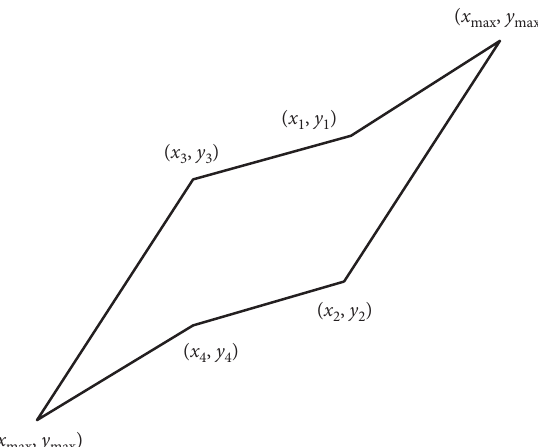
Figure 12: Simplified hysteretic rule of the joint.